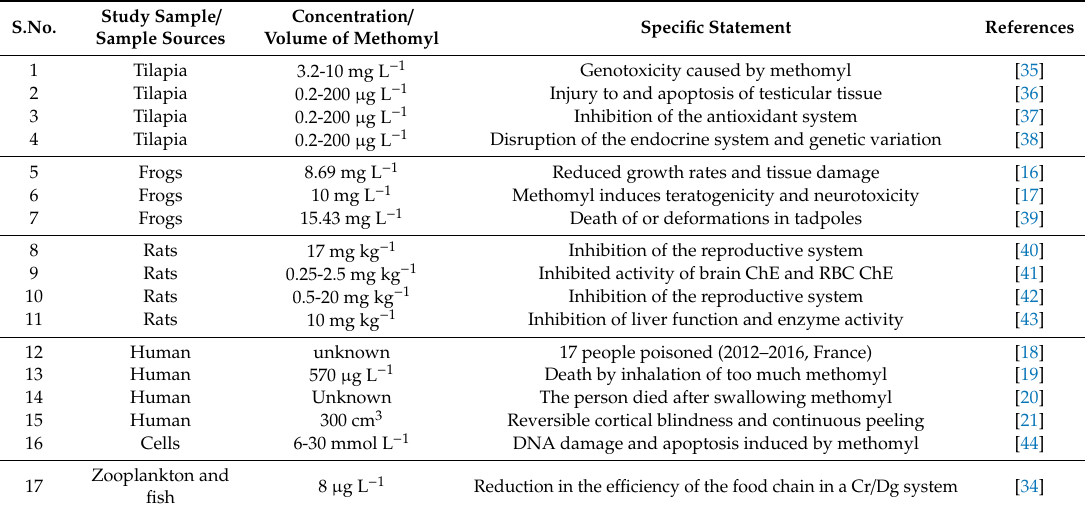
Table 1. Toxicological studies of methomyl in humans and